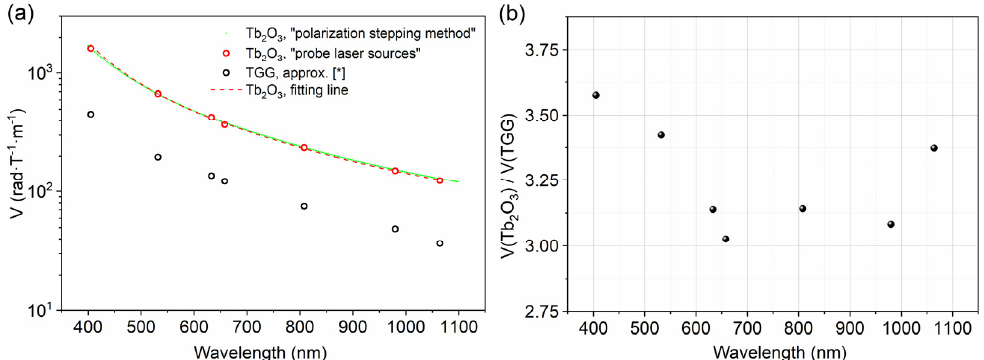
Figure 8. Wavelength dependence of Verdet constant of Tb 2 O 3 ceramics (green dot and red circle) and TGG single crystal (black circle) [58] ( a ), V(Tb 2 O 3 )/V(TGG) ratio versus wavelength ( b ).